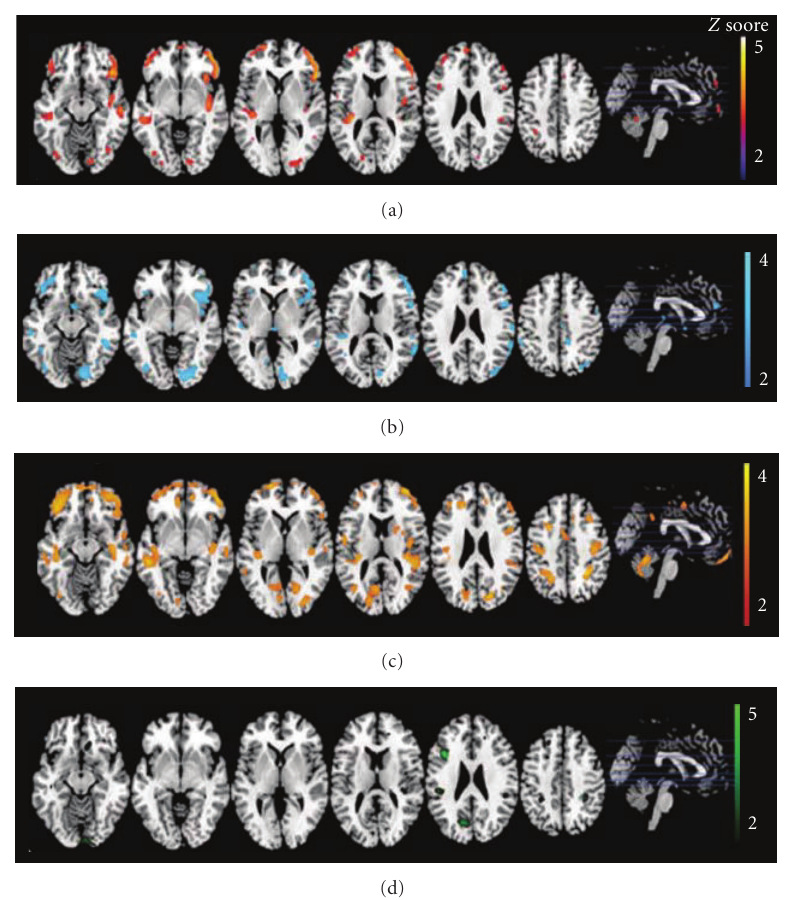
Figure 2: The first 2 rows display maps from subjects with a maternal family history of Alzheimer’s disease (FHm) as compared with subjects with no family history (FH-) (a) and subjects with a paternal family history (FHp) (b). Row (c) shows gray matter volume (GMV) reductions in APOE ε 4-negative FHm subjects compared with APOE ε 4-negative FH subjects. Statistical parametric maps showing GMV reductions in normal FHp subjects as compared with FH subjects are in row (d). Areas of GMV decrease are represented on purple-to-yellow, blue-to- light blue, dark orange-to-yellow, and green-to-light green color-coded scales for the 4 contrasts, reflecting Z scores between 2 and 5 for the upper contrast and between 2 and 4 for the lower 3 contrasts. Areas of gray matter volume decrease are displayed on a standardized spatially normalized MRI (adapted with permission from